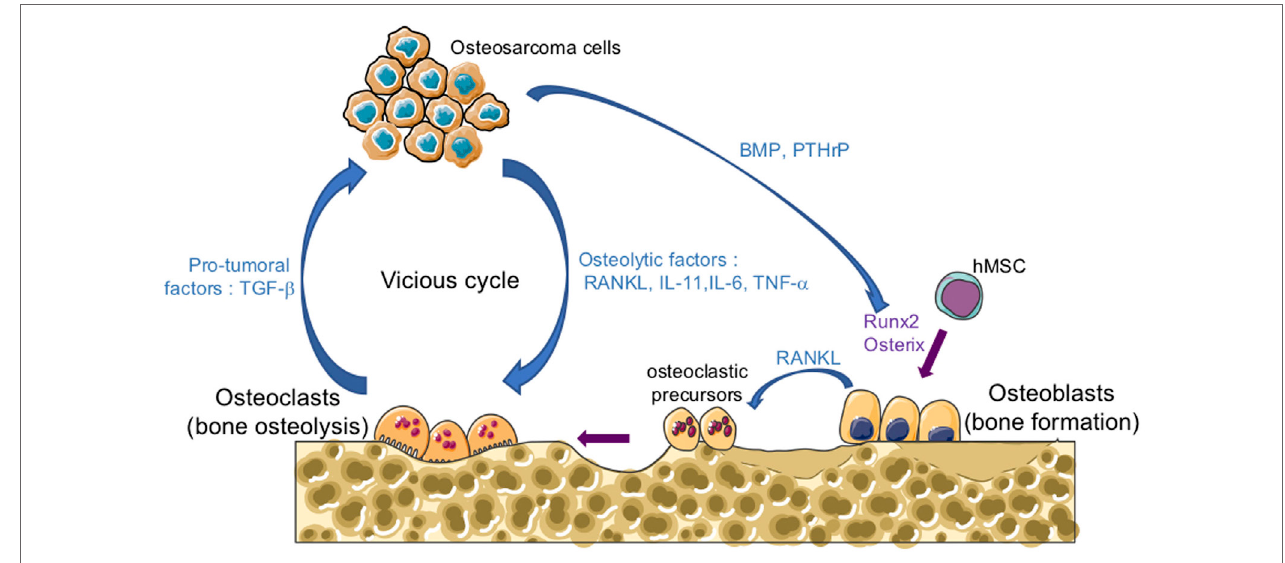
FiGURe 1 | The vicious cycle between tumor and bone cells during osteosarcoma development. Osteosarcoma cells produce soluble osteolytic factors such as receptor activator of nuclear factor kappa-B ligand (RANKL), interleukin-11 (IL-11), IL-6, and tumor necrosis factor- α (TNF- α ) that directly activate osteoclastogenesis, leading to bone degradation. Osteosarcoma cells also produce soluble factors, such as bone morphogenetic protein (BMP) or parathyroid hormone-related protein (PTHrP), which stimulate the production of RANKL by osteoblasts and therefore increase osteoclast activity. Osteoblasts are derived from mesenchymal stem cell in response to transcriptional factors such as Runx2 and osterix. Following bone degradation, the growth factors trapped in the bone matrix, such as transforming growth factor- β s (TGF- β s), are released into the bone microenvironment and stimulate both tumor growth and metastatic progression.